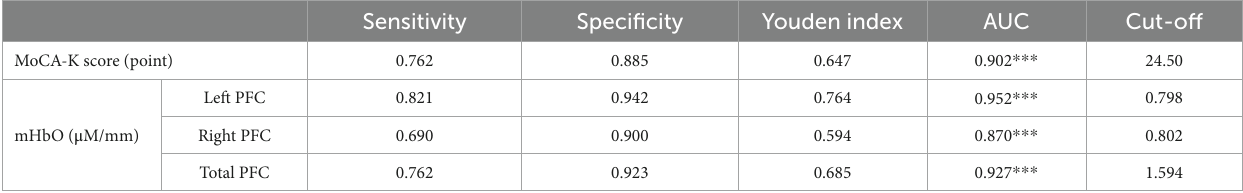
TABLE 3 Sensitivity and specificity of MCI detection via machine learning algorithms compared with original tests ( N = 136).